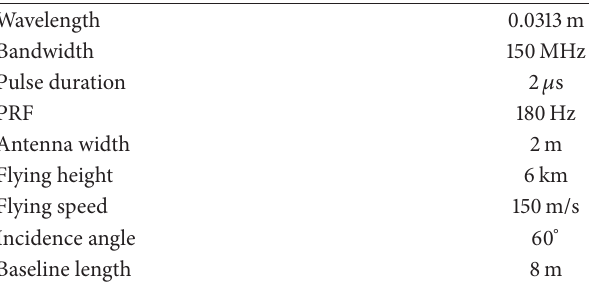
Table 1: Simulation